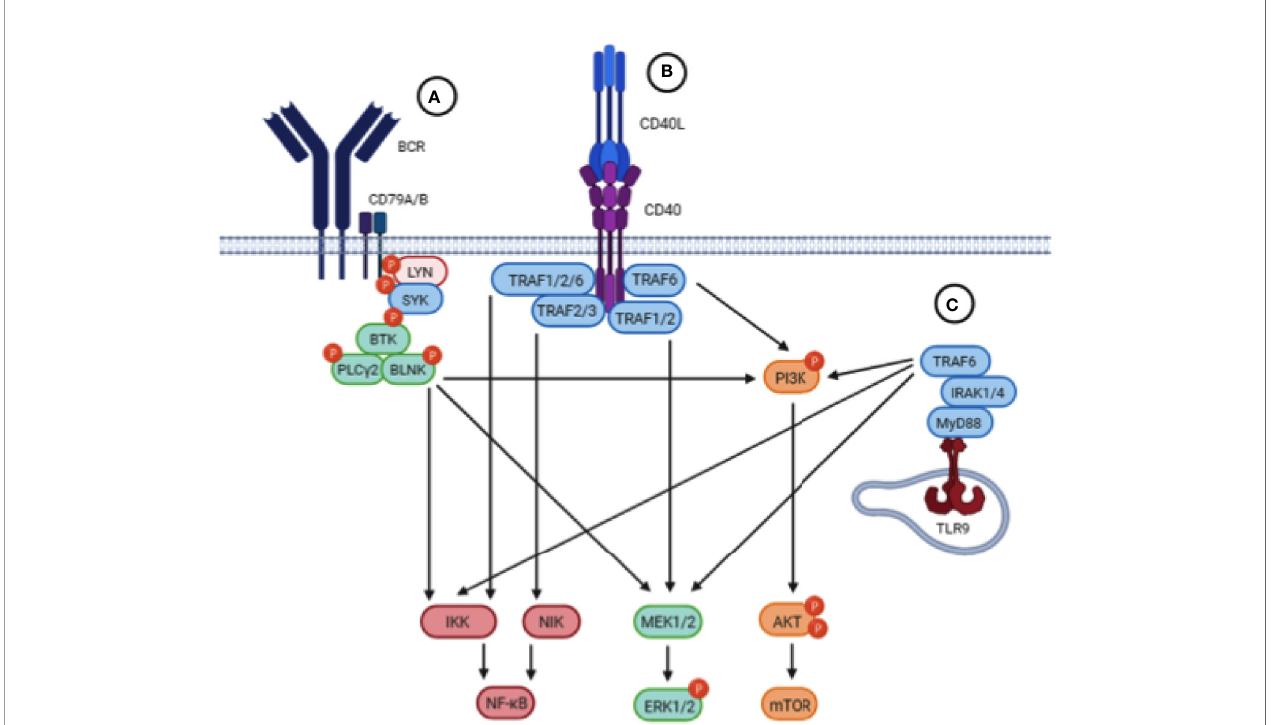
FIGURE 2 | Schematic representation of the BCR, CD40 and TLR signaling pathways. Upstream triggering of BCR, CD40, or TLR signaling lead to activation of similar downstream pathways, including the NF-kB, MEK/ERK, and PI3K/AKT/mTOR pathways. (A) The BCR is composed of an antigen-speci fi c surface membrane immunoglobulin paired with the signal transduction component consisting of the CD79A/B heterodimer. Engagement of the BCR by antigen results in aggregation of BCR components that leads to the phosphorylation of ITAMs in the cytoplasmic tails of CD79A/B which triggers the recruitment and activation of the proximal tyrosine kinases LYN and SYK. Subsequently, BTK is activated which will activate PLC g 2 and BLNK, resulting in activation of downstream signaling pathways. (B) Upon binding of CD40L, the CD40 receptor on CLL cells trimerizes leading to the recruitment of TRAFs to the cytoplasmic domain of CD40. TRAFs may then cooperate in order to activate different signaling pathways downstream. (C) Upon TLR9 activation in the endosomal compartment of CLL cells, the TIR domain of TLR9 engages the TIR domain of the adaptor protein MyD88. MyD88 contains an IRAK1 domain which activates TRAF6, leading to the activation of downstream